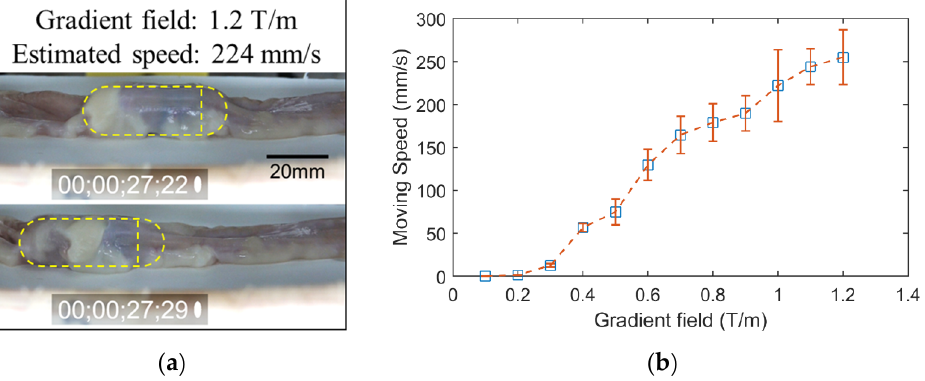
Figure 9. ( a ) Snapshots of capsule movement in the small bowel; the timer is of the format hour;min;sec;frame. The yellow dash line shows the position of capsule endoscope. ( b ) Estimated moving speed of the CE in pig’s small bowel.